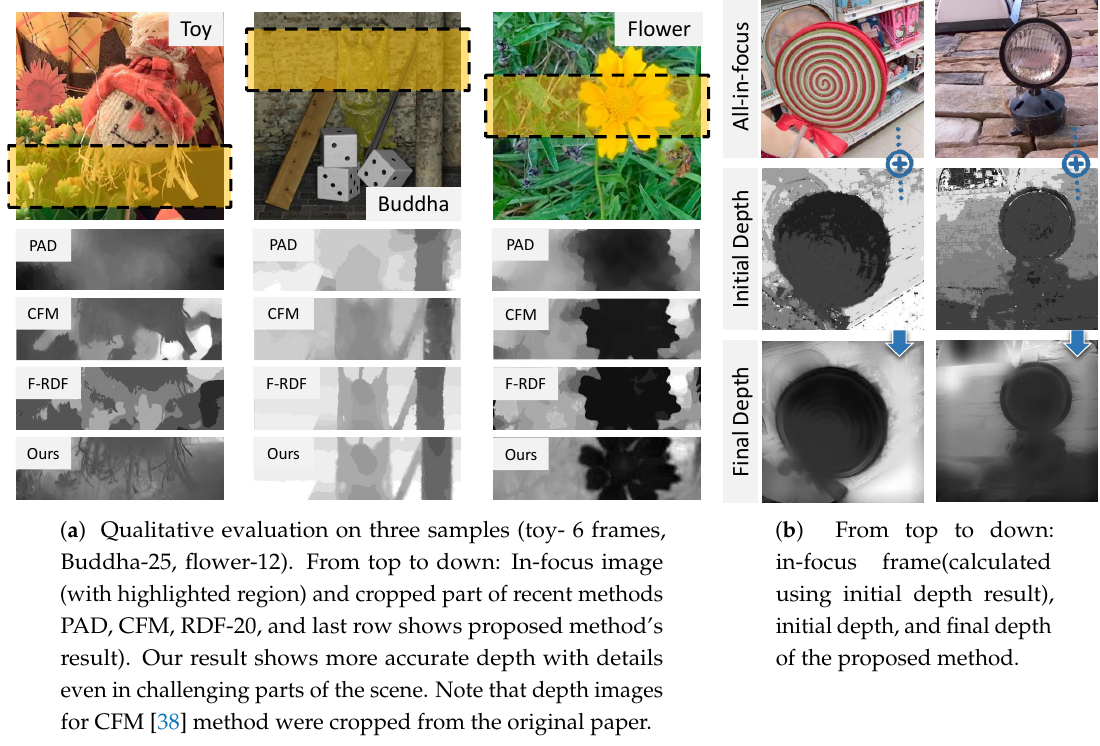
( b ) From top to down: in-focus frame(calculated using initial depth result), initial depth, and final depth of the proposed method.